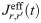
Effective interactions between recorded neurons differ qualitatively from true interactions.Effective interactions Jr,r′eff(t) (solid purple) versus true coupling filters (dashed black) for Nrec = 3 recorded neurons in a network of N = 1000 total neurons. Inset labels i ← j indicate the interaction is from neuron j to i, for i, j ∈ {1, 2, 3}. The simulated network has an Erdős-Réyni connectivity with sparsity p = 0.2 and normally distributed non-zero weights with zero mean and standard deviation 1/pN. Although the network is sparse, the effective interactions are not: non-zero effective interactions develop where no direct connection exists. The effective interactions can differ qualitatively from the true interactions, as evidenced by the biphasic 3 ← 2 effective interaction, whereas the true 3 ← 2 is purely excitatory.